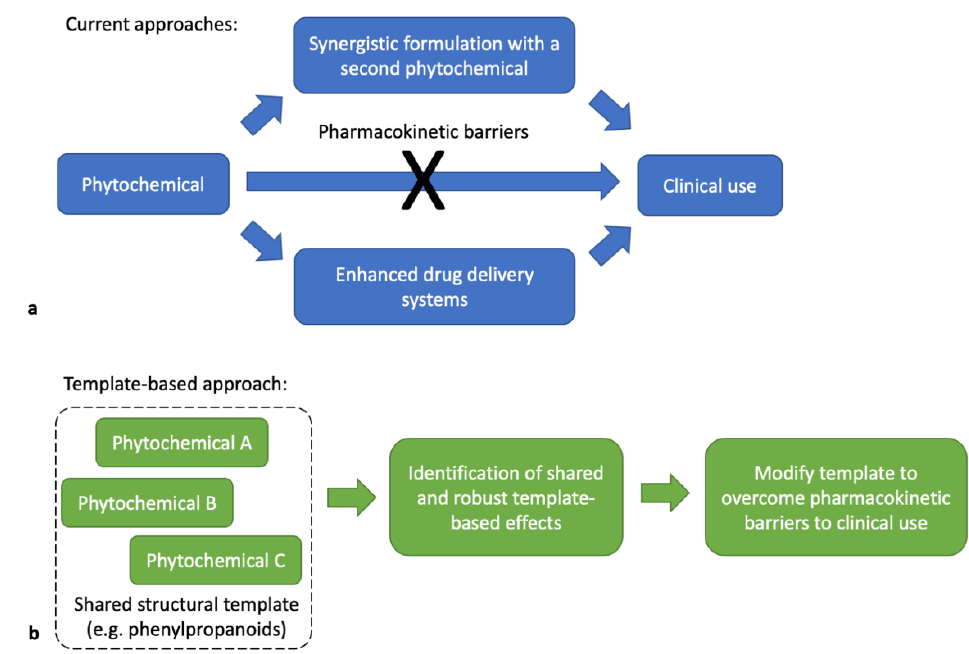
Figure 2. ( a ) Current and ( b ) proposed approaches to formulating phytochemicals as drugs.